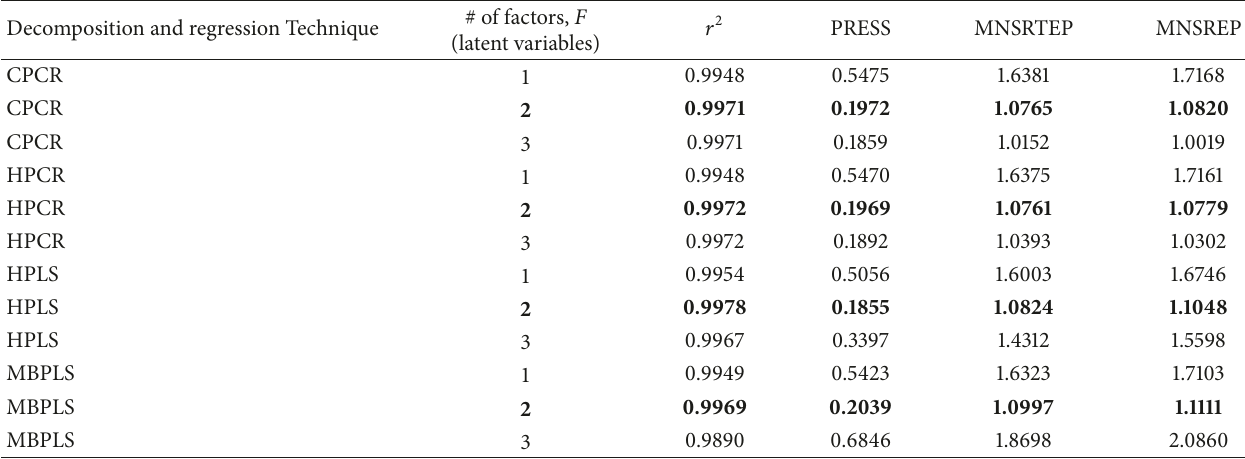
Table 6: 𝑟 2 , PRESS, MNSRTEP, and MNSREP calculated for external validation set for various calibration models for different number of factors. Selected optimum parameters are bolded.